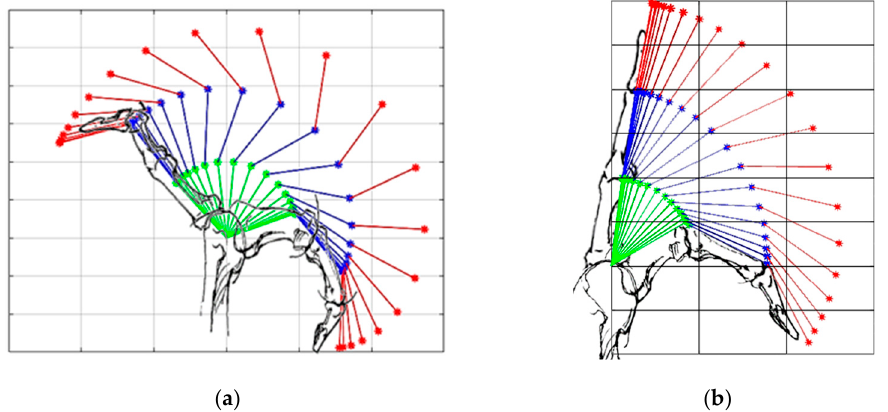
Figure 8. Overall finger extension ( a ) using the traditional mechanism and ( b ) using the proposed mechanism. The green line represents the proximal phalanx, the blue line represents the middle phalanx, and the red line represents the distal phalanx.